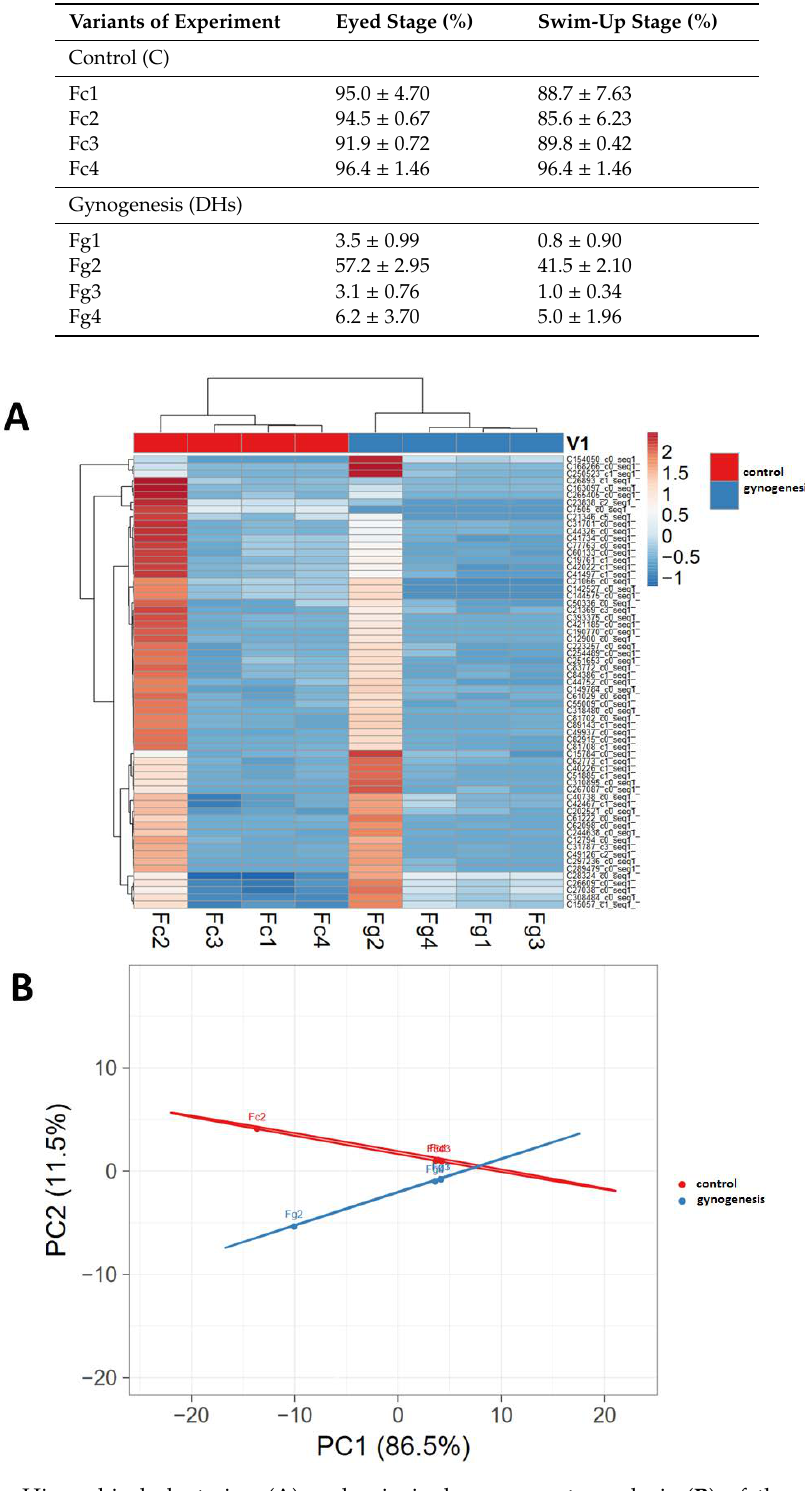
Figure 2. Hierarchical clustering ( A ) and principal components analysis ( B ) of the expression of the transcripts that were the most strongly correlated with the efficiency of gynogenesis. Fc1– Fc4 – transcripts from the non-activated eggs (control) originated from F1–F 4 females, respectively, and Fg1– Fg4 –transcripts from gynogenetically activated eggs (gynogenesis) originated from the same females.